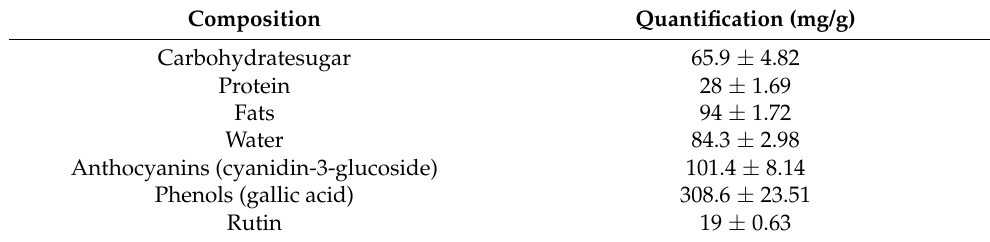
Table 1. Composition analysis of MBE.